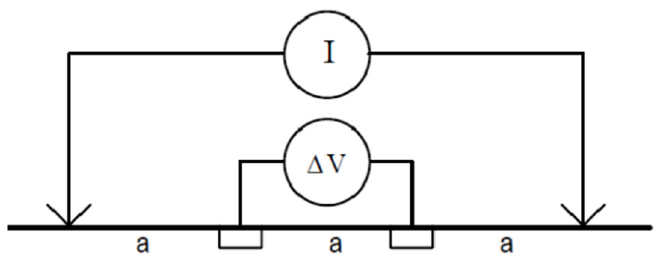
Figure 9 .A scheme for Wenner array. Figure 9. A scheme for Wenner array.